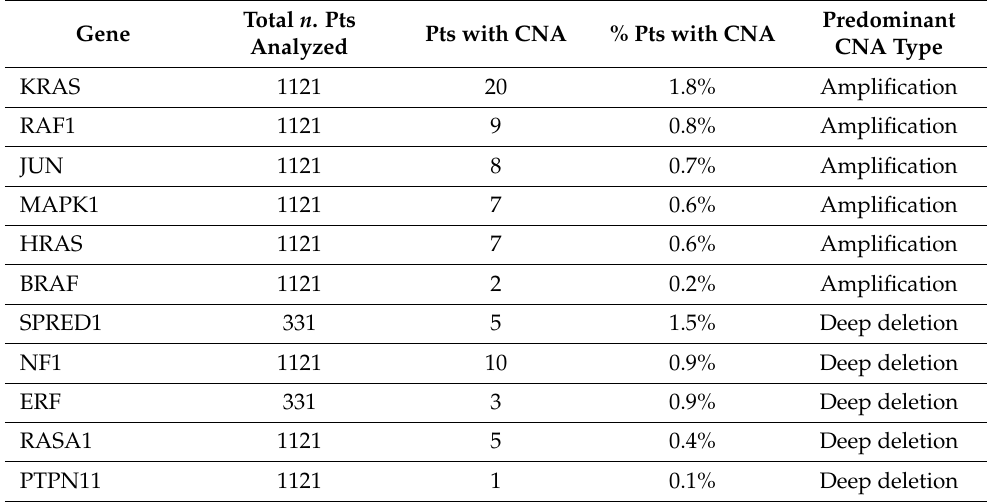
Table 6. Copy number alterations of RAS/RAF/MEK/ERK pathway genes in metastatic breast cancer samples of 1121 patients from two studies (MSKCC and